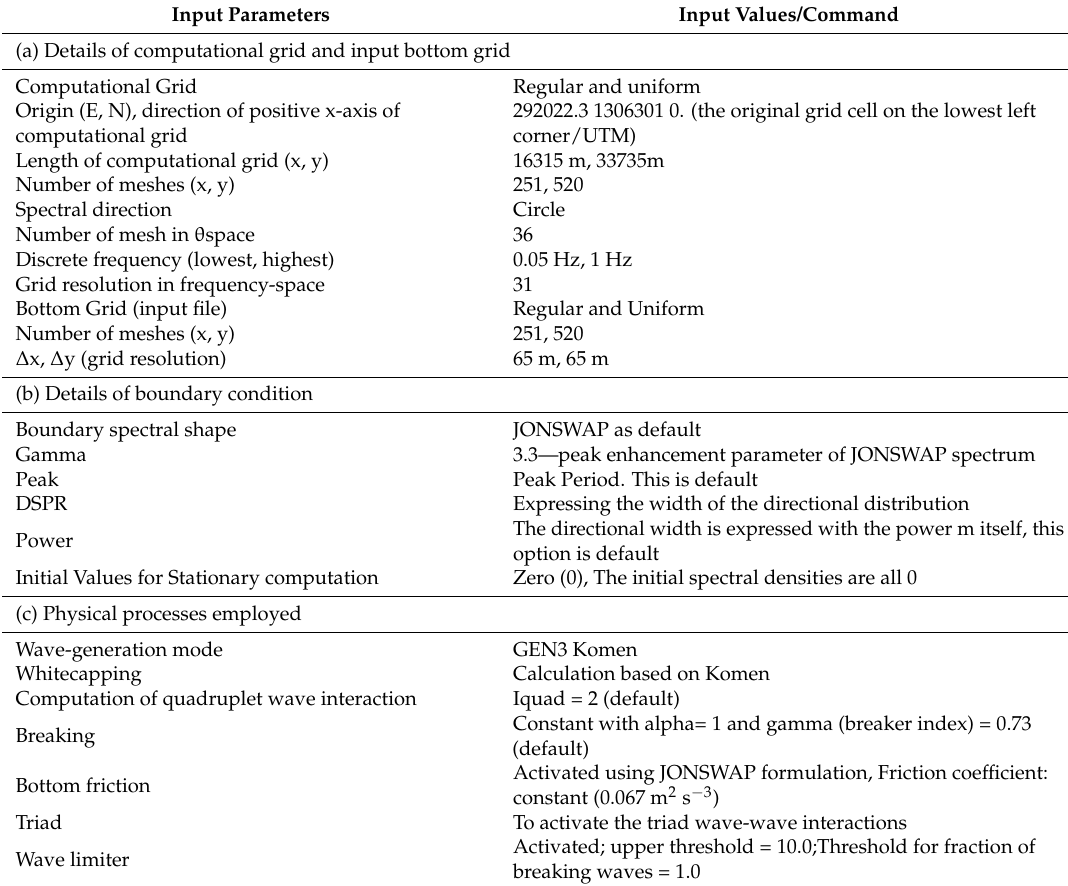
Table 3. Description of computational conditions for SWAN (Simulating WAves Nearshore) model. Input Parameters